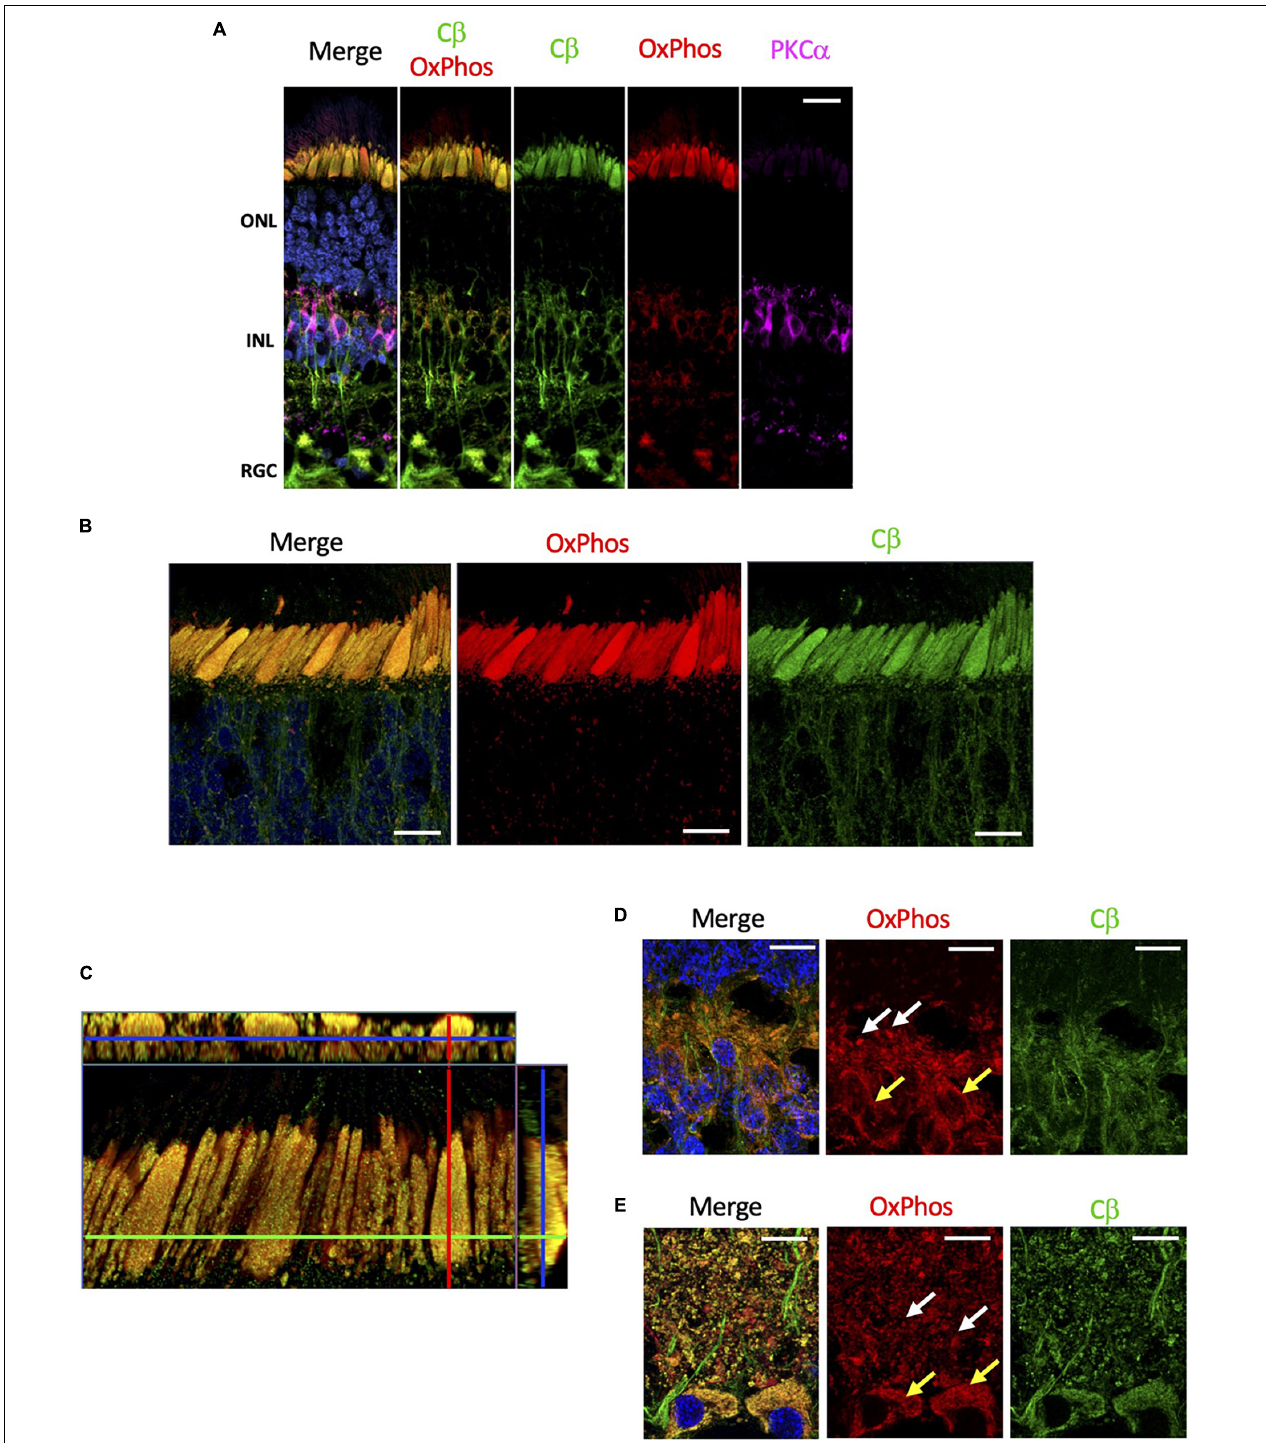
FIGURE 5 | C β is co-localized with mitochondria. (A) All sections were labeled with anti-PKC α antibodies in order to identify rod-bipolar cells (purple), which helped distinguish between the outer nuclear layer (ONL), inner nuclear layer (INL), and retinal ganglion cell layer (RGC). C β (green) and OxPhos(red)-labeled mitochondria co-localize in the ONL, INL, and RGC, with clear signal overlap (yellow, C β OxPhos) in every cell layer. (B) In photoreceptors, C β (green) and OxPhos(red)-labeled mitochondria are distinctly co-localized to the inner segment ellipsoid (yellow, merge). Additionally, C β -positive mitochondria puncta can be visualized below the inner segment ellipsoid. (C) C β and OxPhos-labeled mitochondria co-localize (yellow) to fill the entire inner segment ellipsoid of a single cone cell (outlined). (D,E) C β (green) and mitochondria (red) are clearly co-localized (yellow) in photoreceptor synapses (D) and retinal ganglion cells (E) . Mitochondria localization: white arrows – plexiform layer, yellow arrows – soma. Nuclei in blue, scale bar = 10 µ